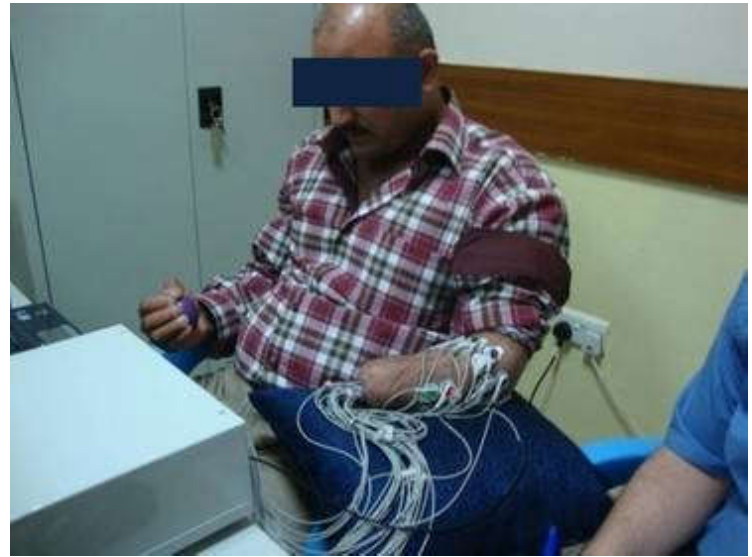
Figure 2. The electrodes locations for EMG data acquisition from an amputee. Source : Electromyo- Figure 2. The position of electrodes for EMG data acquisition from an amputee. Source: Electromyo- gram (EMG) repository (rami-khushaba.com) (accessed on 7 May 2021). gram (EMG) repository (rami-khushaba.com) (accessed on 07 May